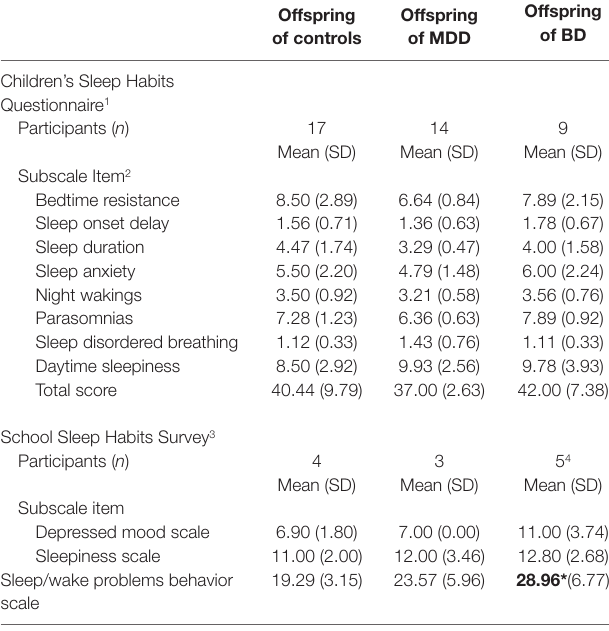
TABLE 2 | Mean and standard deviations of parent-reported Children’s Sleep Habits Questionnaire (CSHQ) total score and subscales by family history group for offspring aged 4–14. Mean and standard deviations of self-reported School Sleep Habits Survey (SSHS) subscales by family history group for offspring aged 15–17.